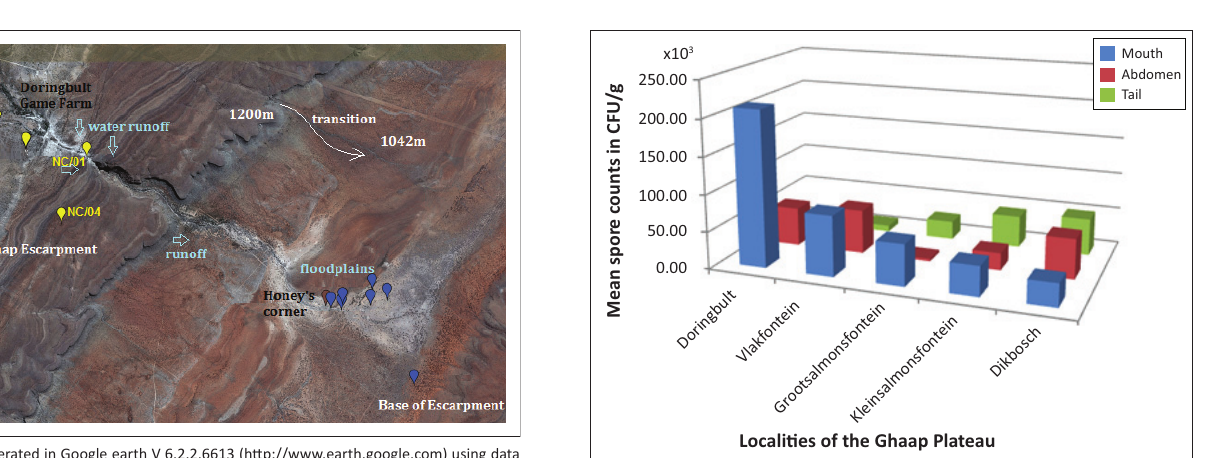
FIGURE 3-A1: Mean Bacillus anthracis spore counts in colony forming units per gram obtained from soil under different parts of anthrax-positive carcasses on farms on the Ghaap Plateau during an outbreak in 2008, Northern Cape, South Africa.